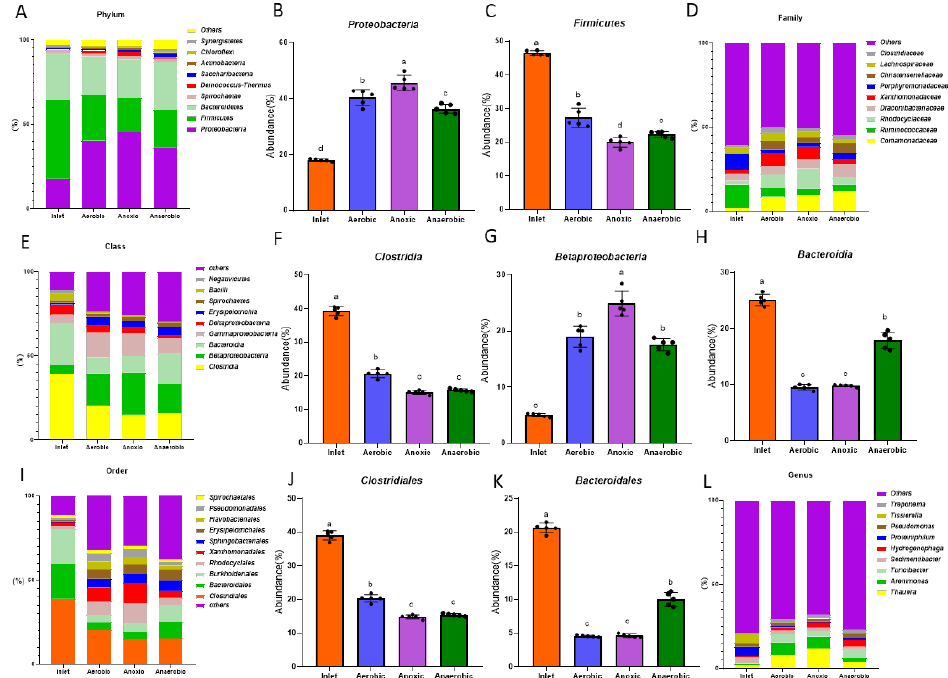
Figure 5. Relative abundance of the microbial community. Note: ( A ) Relative abundance of microbial phyla; ( B ) percentage of Proteobacteria in each sample from the four groups; ( C ) percentage of Firmicutes in each sample from the four groups; ( D ) relative abundance of microbial family; ( E ) relative abundance of microbial class; ( F ) percentage of Clostridia in each sample from the four groups; ( G ) percentage of Betaproteobacteria in each sample from the four groups; ( H ) percentage of Bacteroidia in each sample from the four groups; ( I ) relative abundance of microbial order; ( J ) percentage of Clostridiales in each sample from the four groups; ( K ) percentage of Bacteroidales in each sample from the four groups; ( L ) relative abundance of microbial genes. a, b, c, d without a common letter marked indicate significant differences ( p <